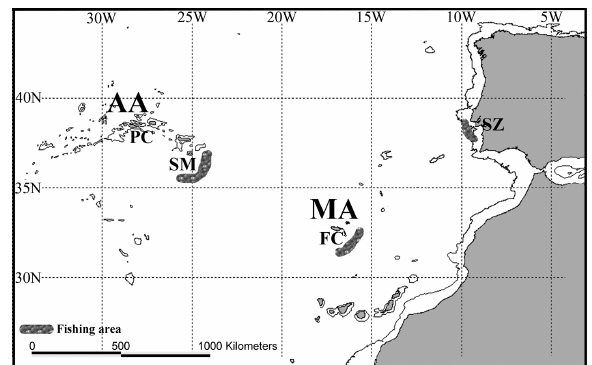
Fig . 1. – Map of the southern northeast atlantic with the sampling locations of black scabbardfish and the 1000 m isobath. aa, azores archipelago; Fc, Funchal; Ma, Madeira archipelago; Pc, Pico is- land: sM, santa Maria island; sZ, sesimbra (mainland